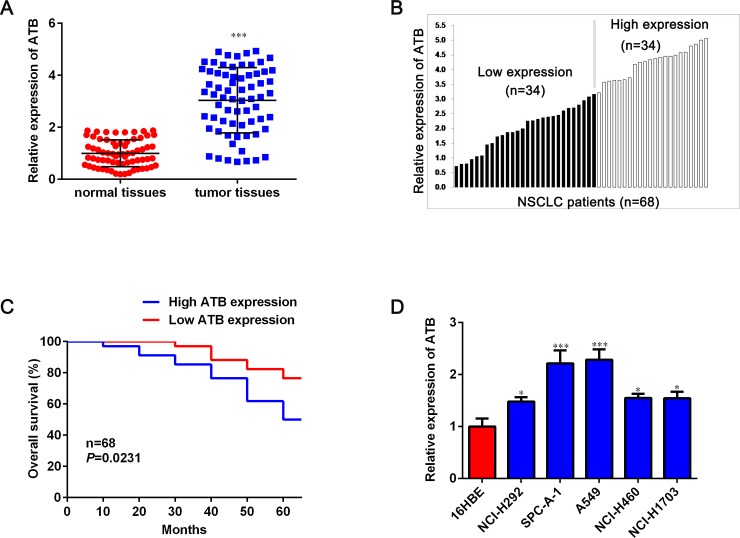
Expression of lncRNA-ATB in NSCLC tissues and its association with clinical factors.A. The lncRNA-ATB expression level in 68 NSCLC tissues and paired adjacent normal tissues was detected by qRT-PCR and normalized to GAPDH expression. B. Samples were divided into a high lncRNA-ATB expression group (34 pairs) and a low lncRNA-ATB expression group (34 pairs) based on the median level. C. The relationship between levels of lncRNA-ATB and overall survival was analyzed by Kaplan-Meier survival analysis. D. RNA levels of lncRNA-ATB in NSCLC cell lines and normal cell line. Data are shown as mean ± SD. *P < 0.05, **P < 0.01 and ***P < 0.001.